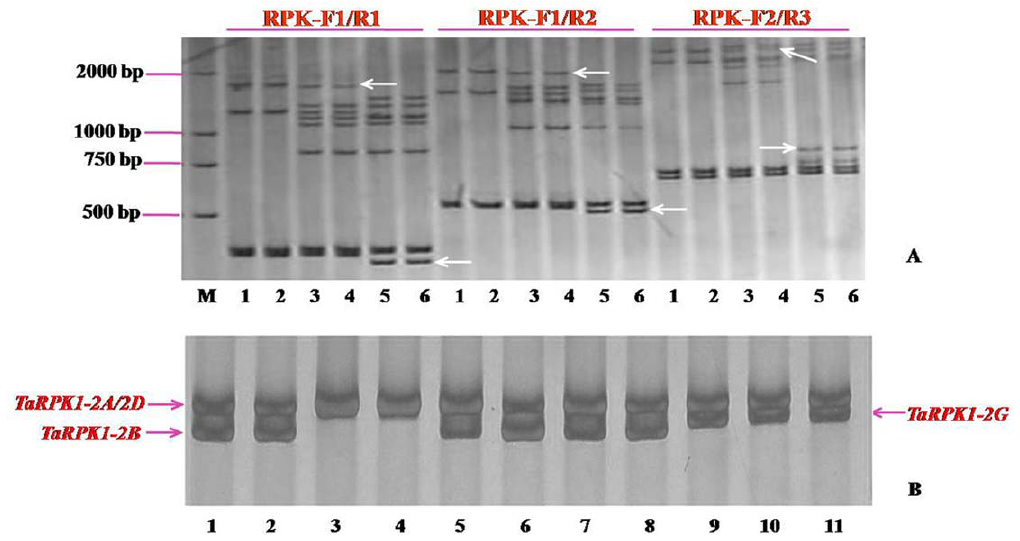
Figure 1. Polymorphic analysis of HvRPK -based STS primer pair amplicons and chromosome location of the RPK amplicons in common wheat. A. Polymorphisms between the Pm6 -carrying powdery mildew resistant lines and susceptible lines (Arrows indicate the polymorphic bands). M: DNA fragment marker DL2000; 1 and 2: Triticum timopheevii (with Pm6 ); 3 and 4: Pm6 -carrying T. aestivum - T. timopheevii introgression line IGVI-465; 5 and 6: susceptible wheat variety Prins. B. Chromosome location of the RPK gene using the homoeologous group-2 ‘Chinese spring’ (CS) nulli-tetrasomic (NT) lines and Pm6 -carrying T. aestivum - T. timopheevii introgression lines. The left arrows show the specific bands from chromosomes 2A or 2D and 2B, and arrow on the right shows the specific band from the chromosome 2G of Pm6 -carrying lines. 1: Nulli2A/ Tetra2B; 2: Nulli2A/Tetra2D; 3: Nulli2B/Tetra2A; 4: Nulli2B/Tetra2D; 5: Nulli2D/Tetra 2A; 6: Nulli2D/Tetra2B; 7: CS; 8: Prins; 9: Pm6 -carrying T. aestivum - T. timopheevii introgression line IGVI-465; 10: Pm6 -carrying T. aestivum - T. timopheevii introgression line IGVI-466; 11: T. timopheevii (with Pm6